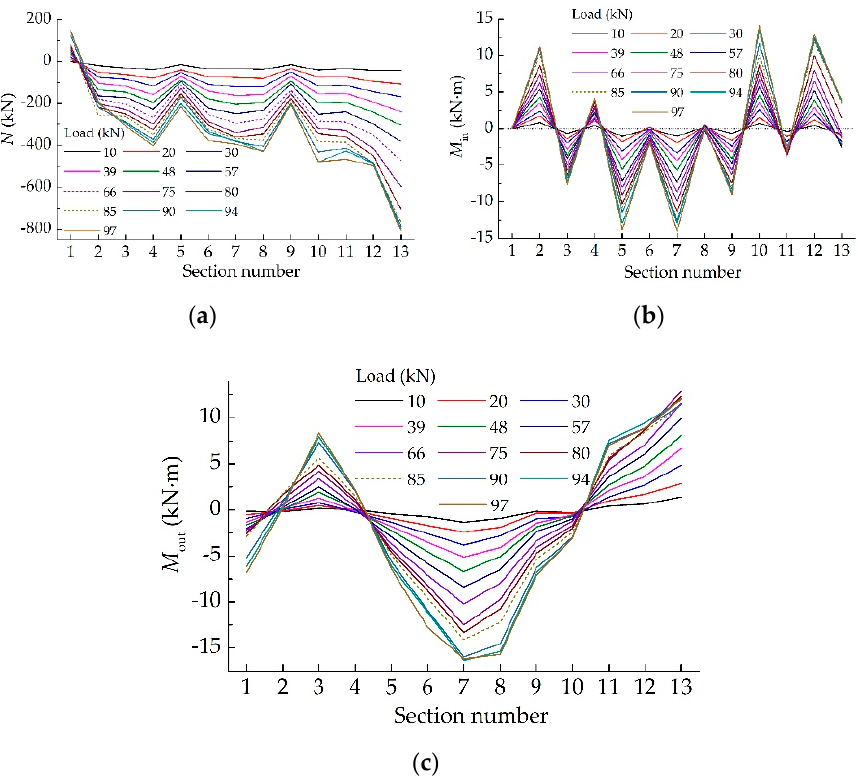
Figure 13. The stressing state submodes for internal forces of arch-B: ( a ) The distribution mode of N ; ( b ) the distribution mode of M in ; ( c ) the distribution mode of M out .